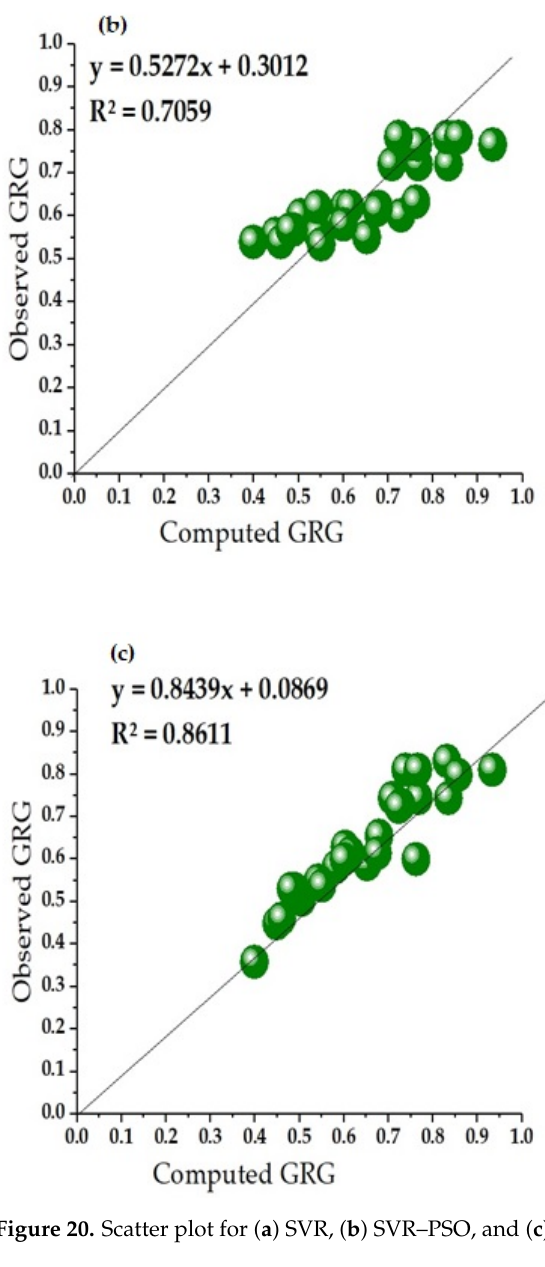
Figure 20. Scatter plot for ( a ) SVR, ( b ) SVR–PSO, and ( c ) SVR–HHO models for all datasets. An overall comparison of the novel AI models in this study was carried out using a two-dimensional Taylor diagram, as depicted in Figure 21. The Taylor diagram describes and sums up many statistical metrics, such as RMSE, R, and standard deviation, between the actual and predicted values. This diagram can explain the goodness of fit of different techniques when compared with other models. Hence, this diagram can be visualized as a series of points against a polar plot. As noticed in Figure 21, the SVR model exhibited lower mimicking of the data pattern, with an R value = 47%. However, when the SVR– PSO and SVR–HHO models were compared, it was seen that their learning capability outperformed that of the SVR model by 16% and 22%, respectively. With respect to the prediction capability of the GRG, the performance of the SVR–HHO model was slightly higher than that of the SVR–PSO model by just 0.2%. These findings culminated in the conclusion that SVR–PSO and SVR–HHO models are sufficient in capturing the complex and non-linear trends of the